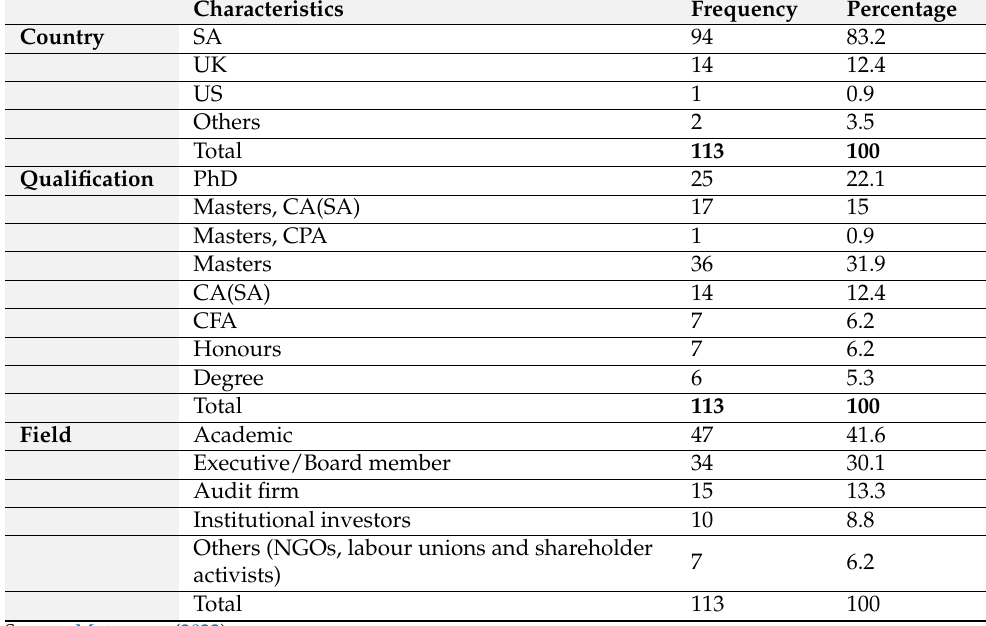
Table 1. Socio-demographic information of the participants. Characteristics